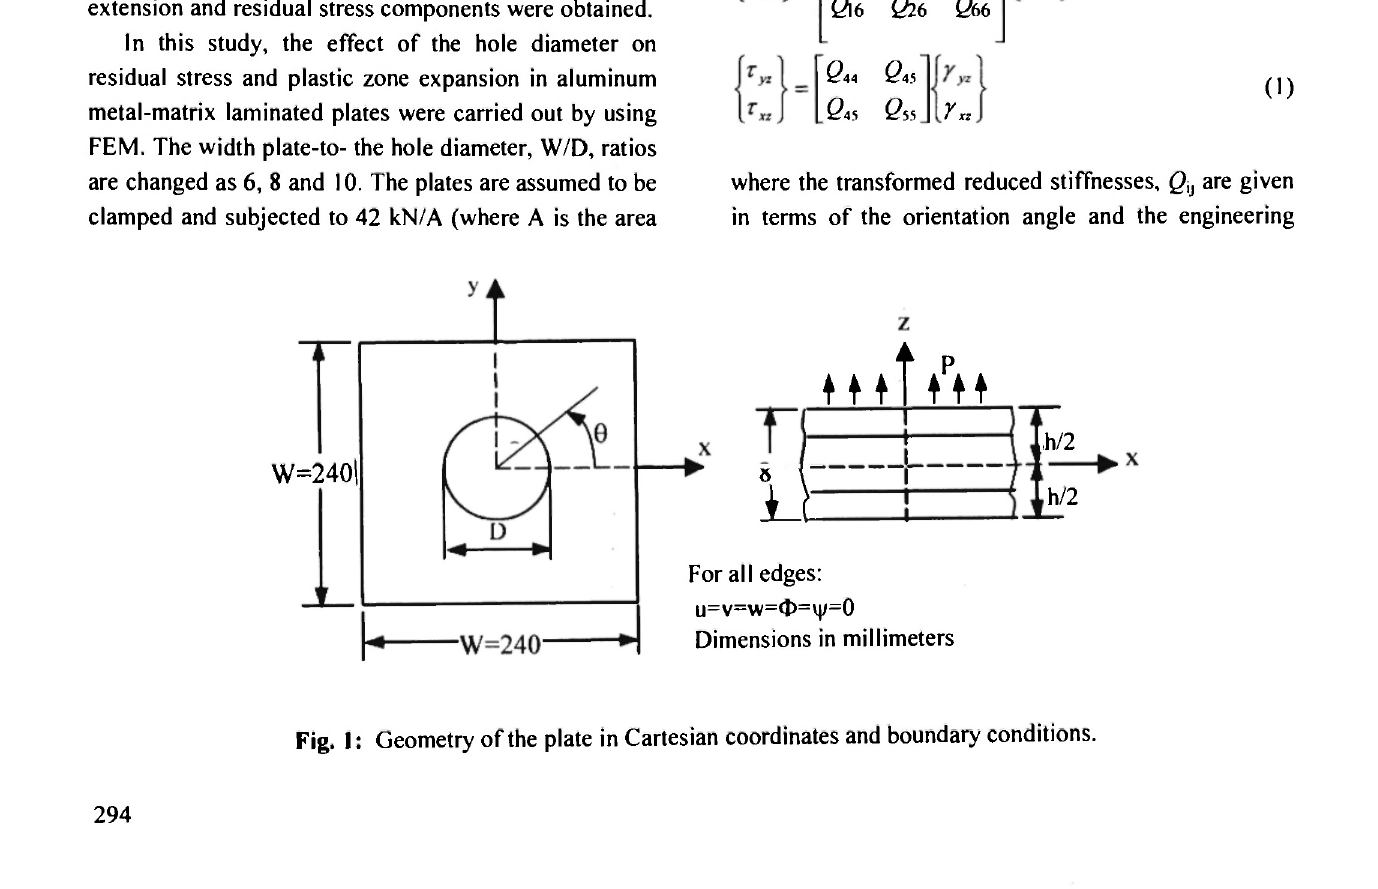
Figure 1. The middle surface of the plate coincides with the x-y plane.